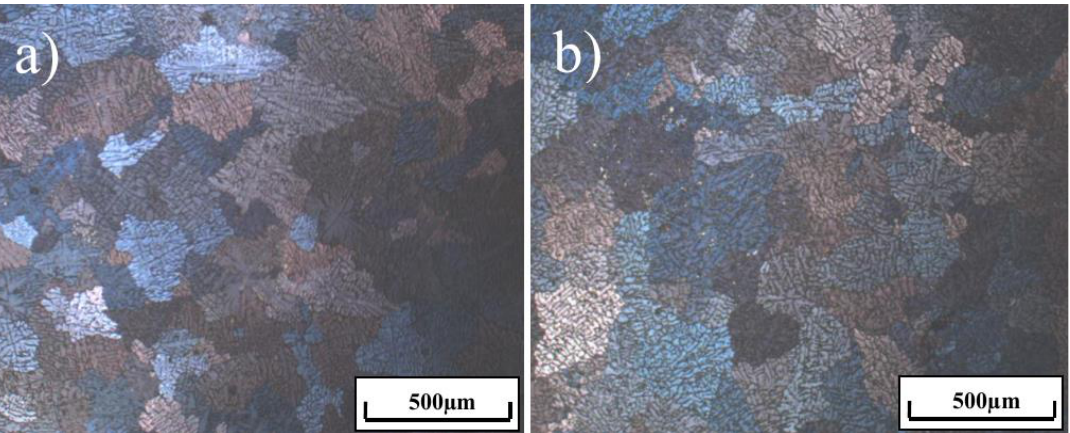
Figure 1. As-cast grain structure of the AlCuYbZr ( a ) and AlCuGdZr ( b ) alloys (LM, polarized light).